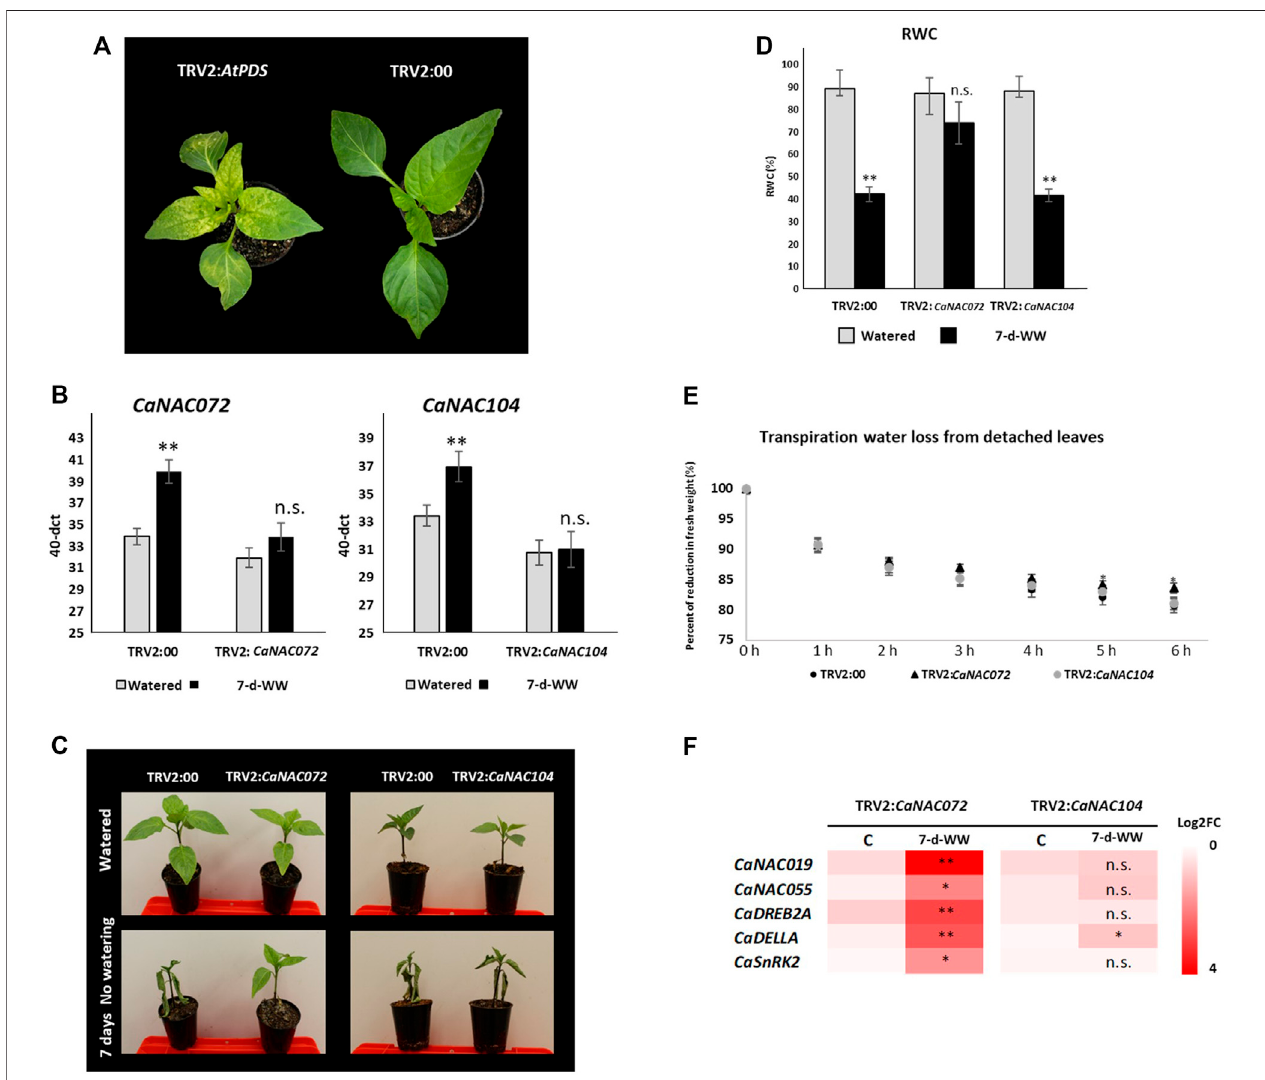
FIGURE 7 | Effect of drought stress on CaNAC072 - and CaNAC104 -silenced pepper plants. (A) Phenotype of a 25-day-old pepper plant after 12 days of agro- in fi ltrationwithTRV2:AtPDS (left) andwiththeemptyvectorTRV2:00 (right) . (B). Expressionof CaNAC072 and CaNAC104 inwell-wateredcontrolplants(greybar)and drought-stressedplants(blackbar)after7 daysofwaterwithholding(7-days-WW),determinedbyqRT-PCR.Datarepresentthemeans ± SD( n (cid:1) 3biologicalreplicates). Values areexpressed asthedifference betweenanarbitraryvalueof40anddCt, sothathigh 40-dCt valuesindicatehighgeneexpression levels.Pepper actin and GADPH genes were used as the reference genes. (C) Phenotype of TRV2:00 vis-à-vis with TRV2:CaNAC072 and TRV2:CaNAC104 plants in watering conditions (upper panel) , and after 7 days of water withholding (lower panel) . (D) Relative Water Content (RWC) of TRV2:00, TRV2:CaNAC072 and TRV2:CaNAC104 plants watered (grey bars) and after 7 days of no watering (black bars). Data represent the means ± SD ( n (cid:1) 15 biological replicates). (E) Trend of leaf fresh weights over 6 h (indexofwaterloss)indetachedleavesofTRV2:00,TRV2:CaNAC072andTRV2:CaNAC104plants.Datarepresentmeans ± SDof15biologicalreplicates. (F) Heatmap showing the log2 fold change (FC) differences in the expression of fi ve pepper genes (i.e., CaNAC019 , CaNAC055 , CaDREB2A , CaDELLA and CaSnRK2 ) which are orthologues of Arabidopsis drought-responsive genes, in TRV2:CaNAC072, TRV2:CaNAC104, and TRV2:00 plants watered and after 7 days of water withholding. Transcript levels were evaluated by qRT-PCR. Data represent the means of three biological replicates per assay. Asterisks indicate statistically signi fi cant differences between CaNAC072 -non silenced and CaNAC072 -silenced plants, and between CaNAC104 -non silenced and CaNAC104 -silenced plants according to Student ’ s t -test; * p < 0.05, ** p <